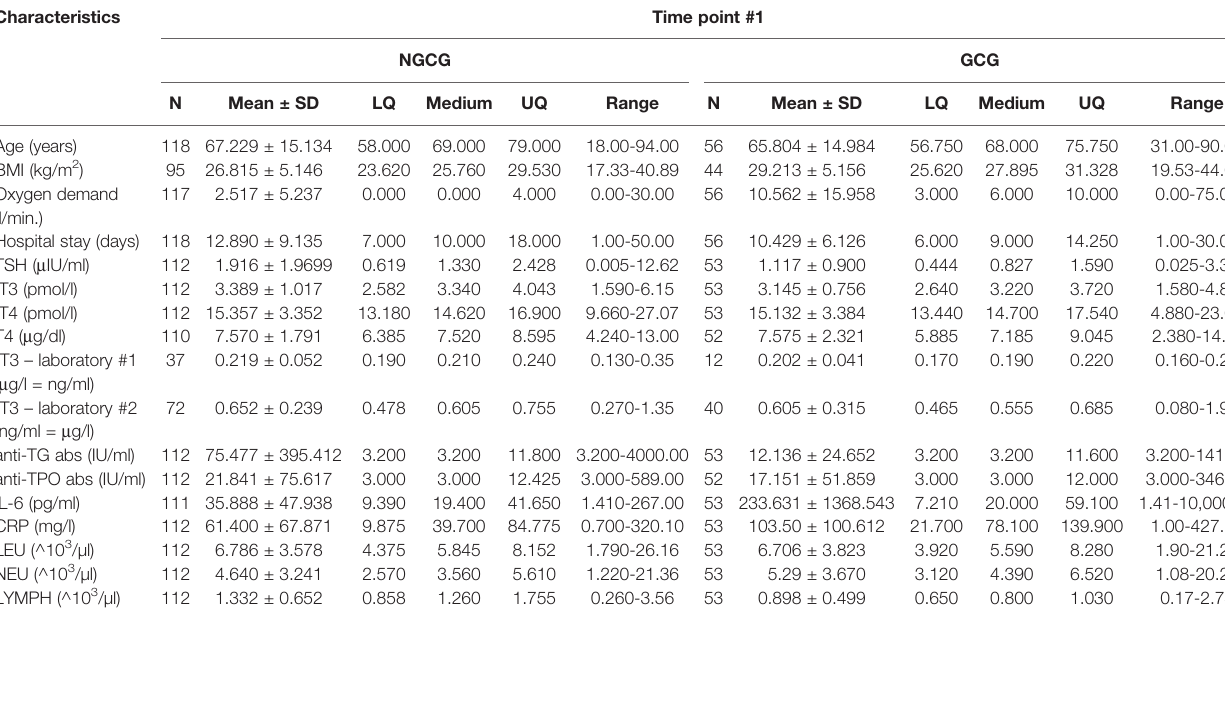
TABLE 3 | Chosen clinical and laboratory parameters – time point #1. Characteristics